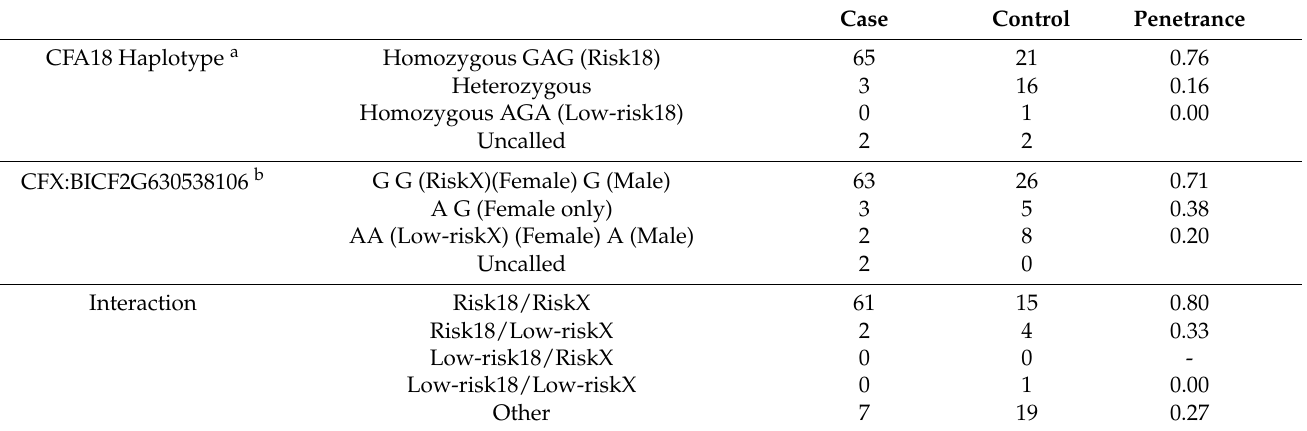
Table 2. Haplotype risk for the CFA18- and CFX-associated